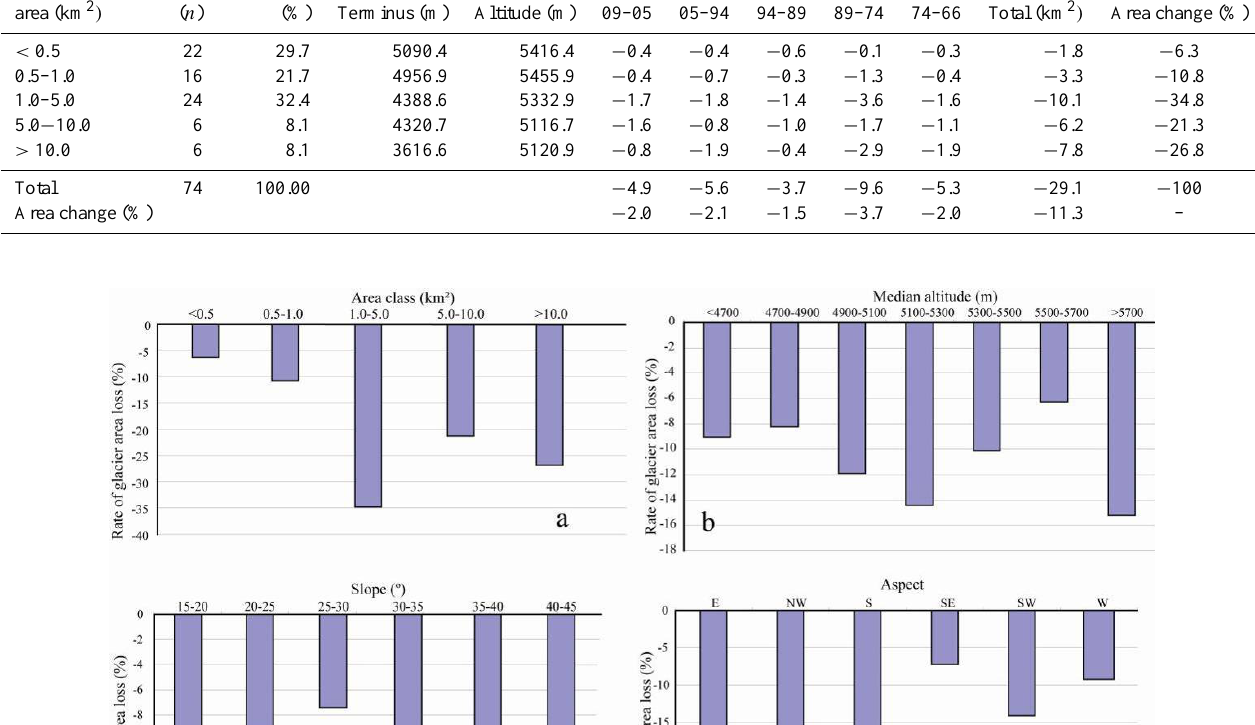
Table 4. Comparison of glacier area for 74 glacier units from three different inventories: CGI (1966), Landsat MSS (1974), Landsat TM (1989, 1994 and 2005) and ASTER (2009). The area in 1966 is used as reference for area comparisons. Interval